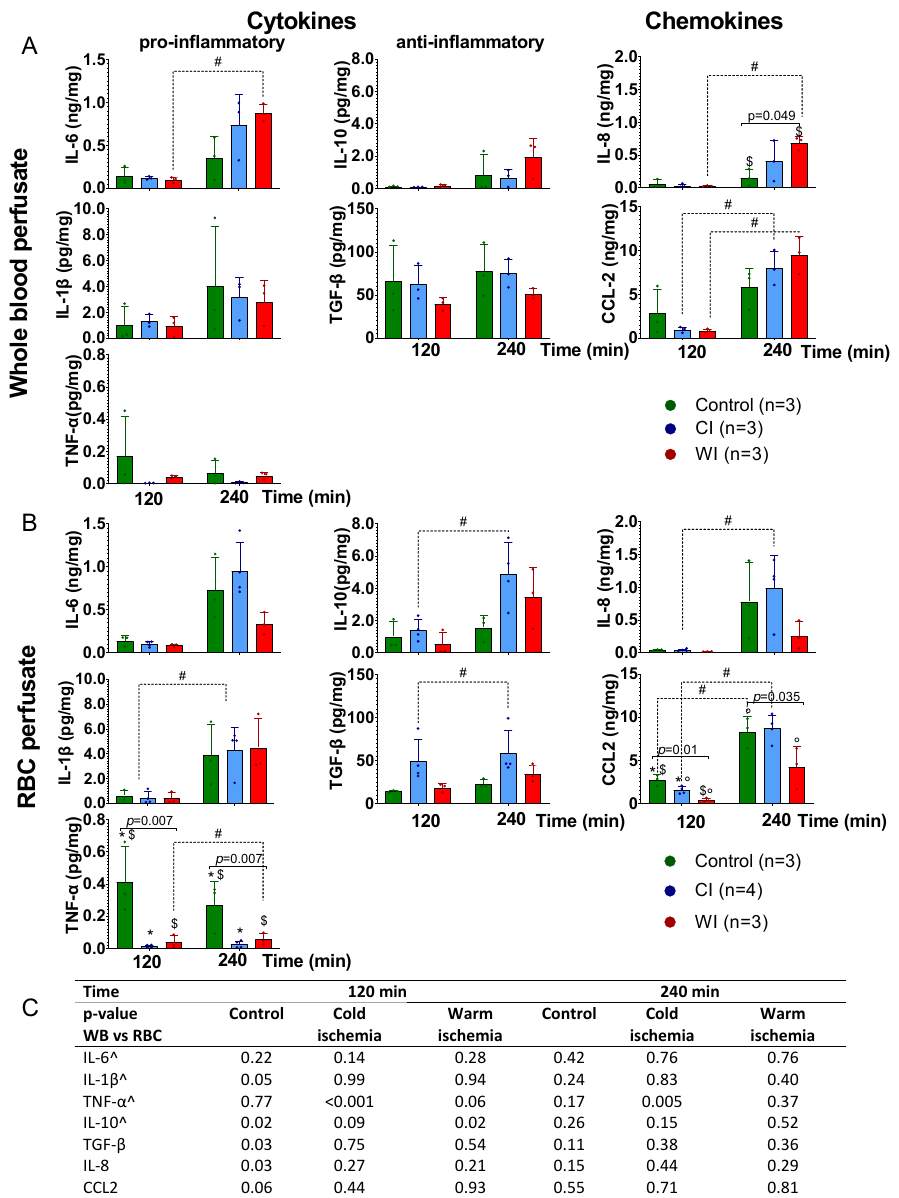
Figure 1. Perfusate cytokine concentrations during normothermic perfusion of pig kidneys exposed to different ischemic injury and perfused with either a whole blood or red blood cell based perfusate. ( A ) Perfusion with autologous whole blood. Pig kidneys were exposed to no important ischemic insults (control); 22 h of cold ischemia (CI) mimicking clinical kidney transplantation; or 60 min of warm ischemia (WI) mimicking anoxic/hypoxic acute kidney injury). ( B ) Perfusion with a concentrated autologous red blood cell perfusate (Table S1). ( C ) Perfusate cytokine concentrations were comparable between perfusions with whole blood and red blood cells, and the same was true for each experimental condition. Significant pairwise comparisons are denoted by a dotted line, in which # indicates a p < 0.05; significant comparisons between ischemic conditions are denoted by a full line, and exact p ‐ values with significant posthoc comparisons indicated by * for control vs CI, ° CI vs. WI, and $ control vs. WI. ^ denotes cytokines with a considerable number of measured concentrations below the lower limit of detection (Table S5). CI, cold ischemia; RBC, red blood cells; WB, whole blood; WI, warm ischemia.